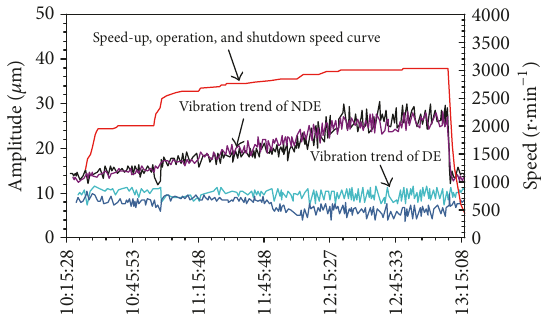
Figure 9: The vibrational trend of cylindrical bearing-rotor